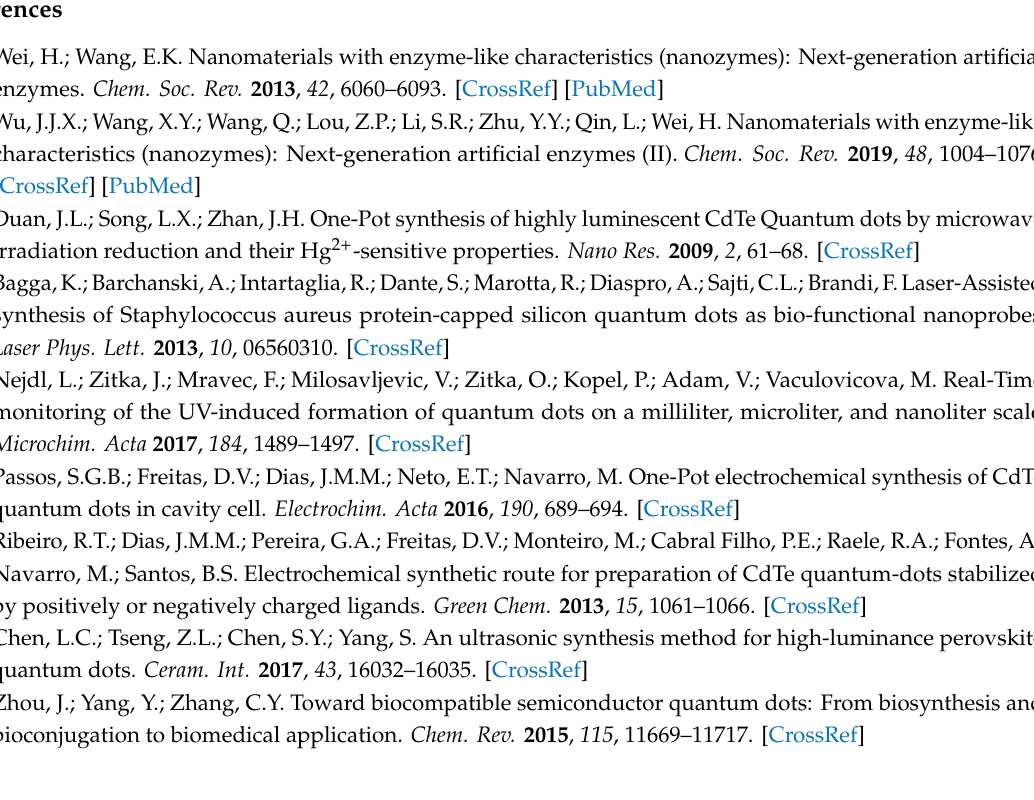
Figure S1: Precursors (Zn:Cd:MSA in phosphate pH 7) were irradiated by UV for 5 min and fluorescence mapping was performed in excitation range 240–380 nm and emission spectra of ZnCd QNPs were recorded in range 400–680 nm, Figure S2: Band gap tuning (emission properties at λ ex = 250 nm in emission range 300–800 nm, manifested as a red shift) of ZnCd QDs containing (a) Zn(II), Cd(II) and 4 mM MSA in phosphate bu ff er pH 7 after 2 (blue), 4 (red), 8 (green), 16 (purple) and 32 (light blue)-minute UV irradiation and / or (b) ZnCd QDs containing Zn(II), Cd(II) and 2 (light blue), 4 (purple), 8 (green), 16 (red) and 32 (blue) mM MSA in phosphate bu ff er pH 7 after 4 min UV irradiation. (c) Schematic illustration of the change in energy levels as a function of QDs size, Figure S3: (a) Schematic representation of balloon stratospheric platform with six cuvettes attached under the probe (exposed UV) and two cuvettes placed in the probe (unexposed UV). (b) The trajectory of flight with duration approximately of 150 min. (c) ZnCd QDs emission spectra at λ ex = 250 nm in range 300–800 nm, recorded after landing of stratospheric (balloon) platform, Figure S4: (a) The comparison of standard redox potential (V) with band gap energy (eV) of standard inorganic ZnS, CdS and proposed ZnCd QDs and important biological reactions corresponding to standard redox potential and band gap energy. (b) Schematic representation of solar driven (formation) nanoparticles and their features in origin of life context. Nanoparticles are able to participate as catalysts in a number of specific (nanozymatic) or non-specific reactions that are relevant to prebiotic chemistry and therefore could be co-assisted with the formation primitive prebiotic photodynamic redox chemical networks with proto-enzymatic activity and could progressed into the metabolic-like networks and life (protocell) on early Earth, Figure S5: Absorption spectra obtained from XO substrate mixed with ZnCd QDs precursors and irradiated for 0 min (a) and for 5 min (b) by visible light. Table S1: First 96 Well Plate, Table S2: Second 96 Well Plate, Video S1: Formation of fluorescent nanoparticles by UV